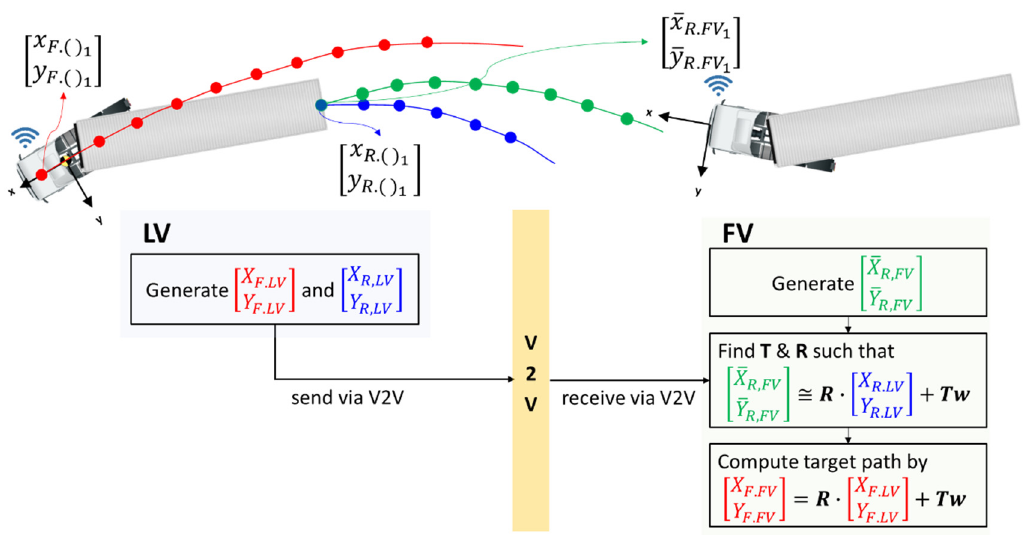
Figure 15. Schematics of path planning.